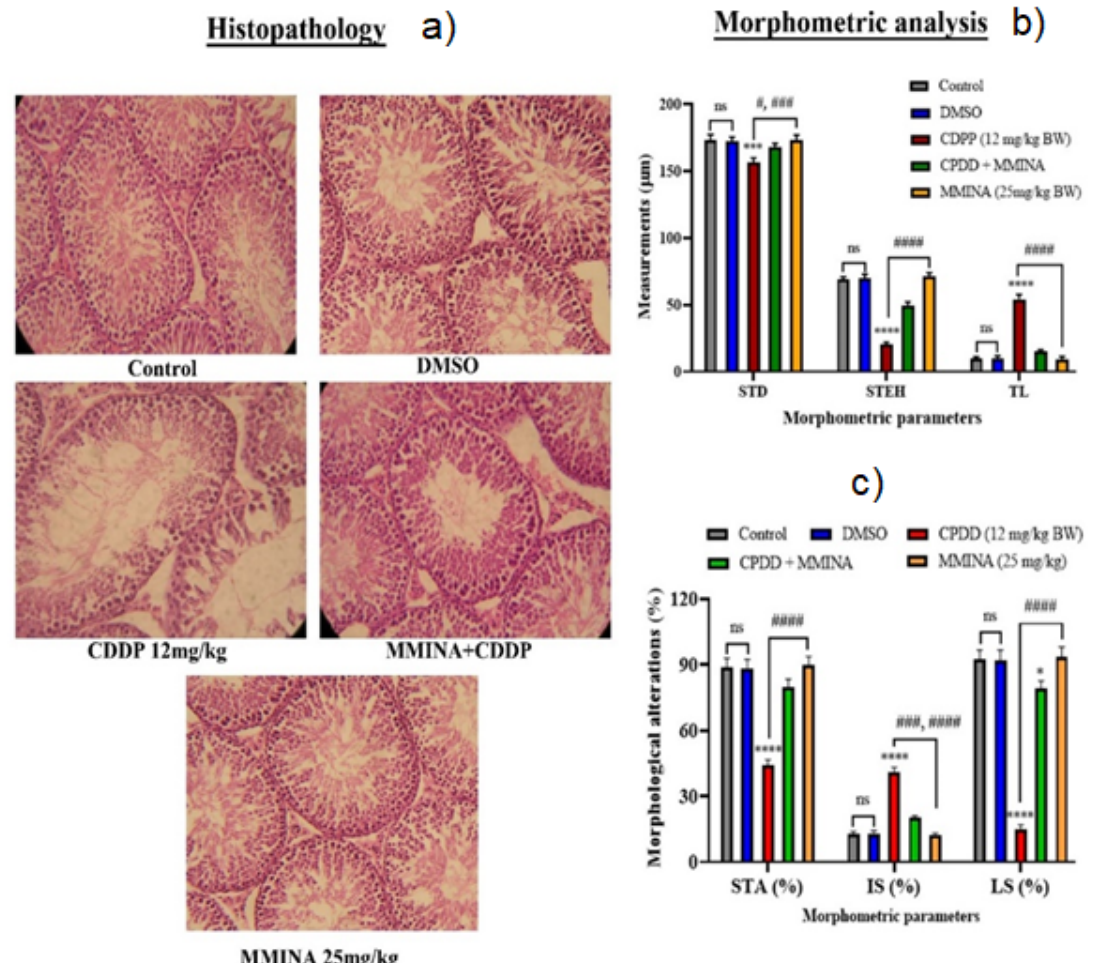
Figure 5. Light micrographs of testicular tissues of rats treated with MMINA and CDDP. Sections were stained with hematoxylin and eosin (40x). ( a ) Photomicrograph of the testicular tissues from various treatment groups. Control group showing typical seminiferous tubules structure at all stages of spermatogenic and the interstitial cells with Leydig cells filling the space between the sem- iniferous tubules. The CDDP (12 mg/.kg b.w) treatment group showed degenerative alterations